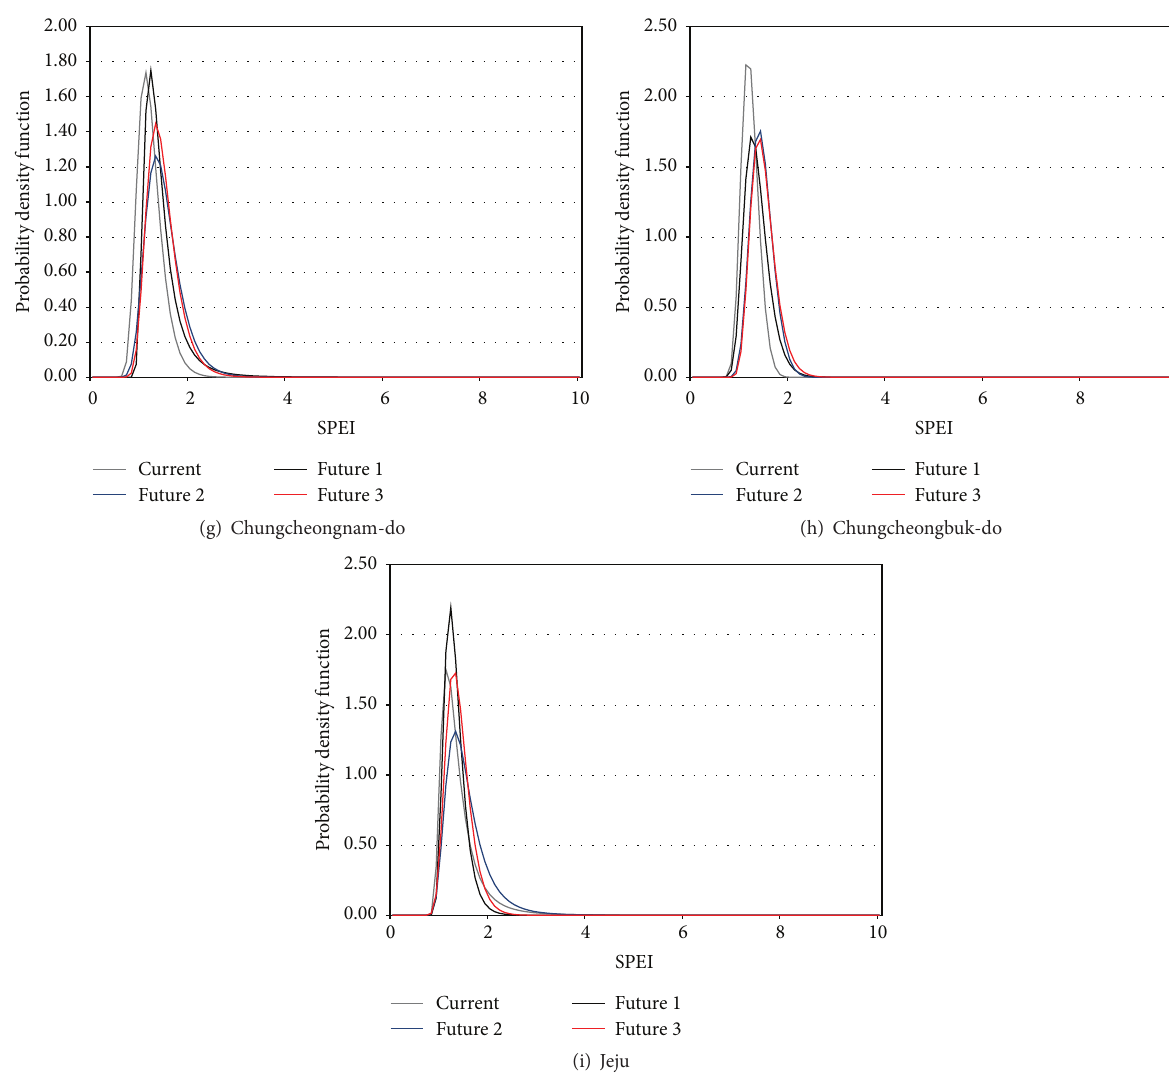
Figure 6: GEV PDF projection of drought magnitude according to administrative